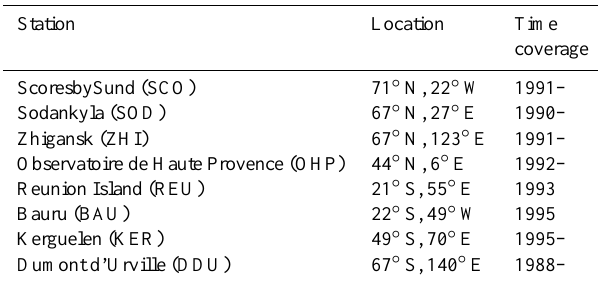
Table 5. List of the SAOZ stations used in the